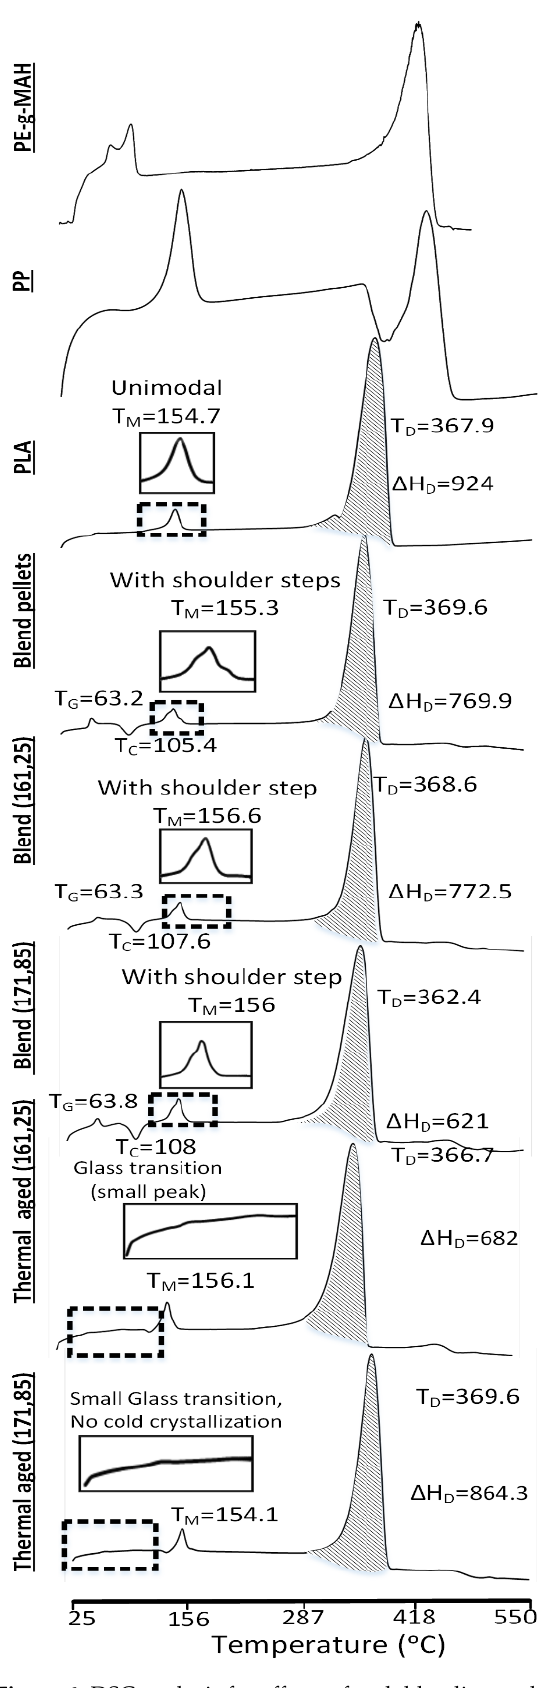
Figure 6. DSC analysis for effects of melt blending and thermal treatment (aging).